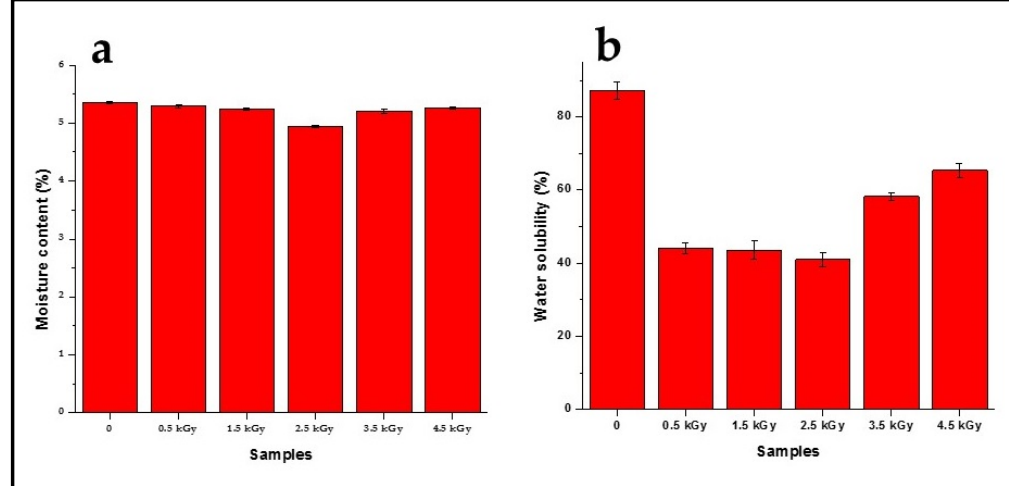
Figure 3. The ( a ) moisture content and ( b ) water solubility of seaweed-neem films at different doses of radiation.